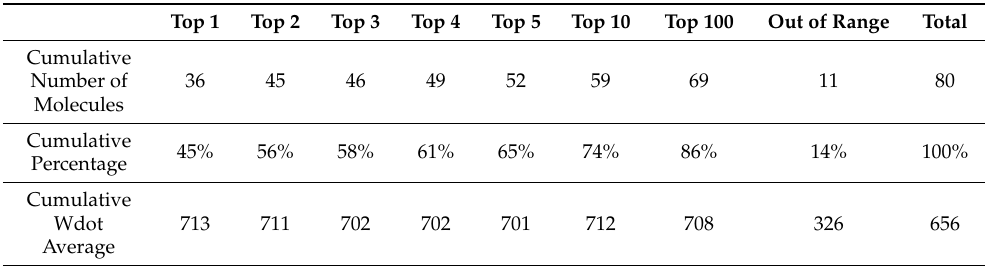
Table 1. Ranking the number of correct structure identifications when matching 80 QCEIMS purine and pyrimidine spectra molecules against the full NIST 17